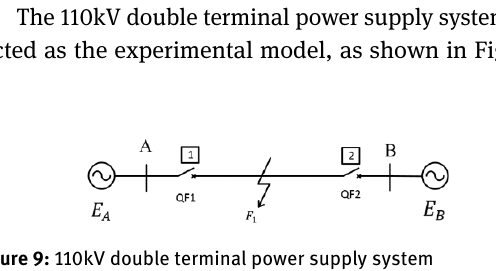
Figure 9: 110kV double terminal power supply system